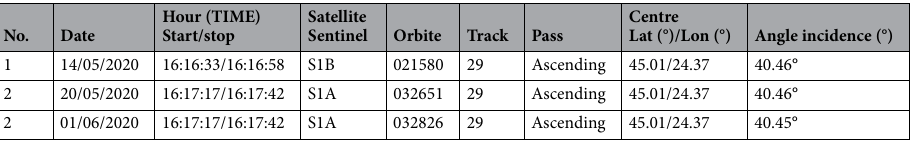
Table 3. Characteristics of the SAR radar data of the Sentinel-1A/B satellites used. Production type : GRD. Acquisition mode : IW. Mission : Sentinel-1. Polarisation VH et VV. Instrument abbreviation: SAR-C